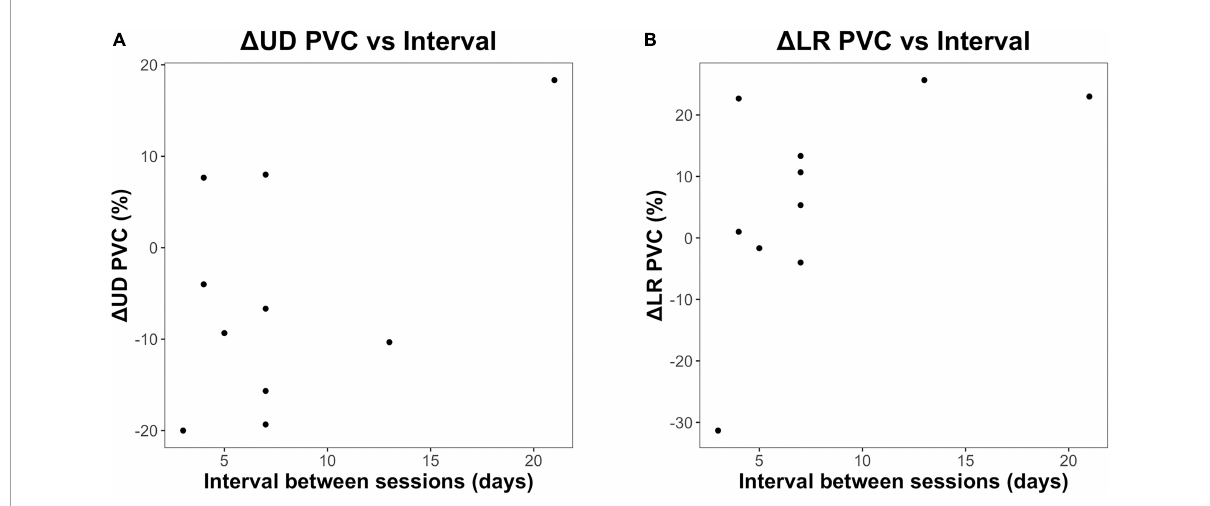
FIGURE4 Scatter plots of difference in change in BCI performance with respect to the interval between sessions in number of days. (A) Difference in the change in LR PVC across the two sessions with respect to the interval between sessions. (B) Difference in the change in UD PVC across the two sessions with respect to the interval between